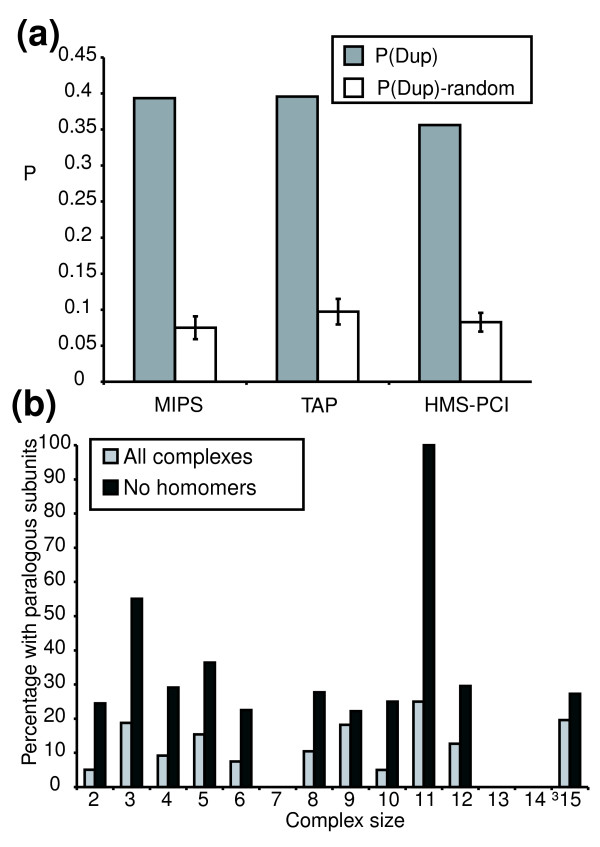
Duplication of subunits in protein complexes. (a) Nearly 40% of the protein complexes have homologous subunits (gray bars). These levels are higher than expected by chance (white bars). Random expectation levels are the averages of 10,000 randomized protein complex datasets, where the complex size distribution is kept constant. While the MIPS dataset is the result of manual curation (see table 1), both TAP and HMS-PCI are the result of large-scale experiments, and some redundancy may exist from multiple baits picking up the same complex. For the TAP dataset, the authors provide a smaller set of predicted complexes based on bioinformatics methods. We repeated the calculation on this set of predicted TAP complexes and found that 47% of the complexes have duplicated subunits, while 18 ± 2% would be expected at random. The significance level remains the same for this predicted set of complexes as for the raw purification data. (b) Percentage of complexes of known three-dimensional structure that have duplicated subunits, as a function of complex size. Grey bars are for the complete data set, whereas black bars are from a dataset that excludes purely homomeric complexes, as these dominate the dataset (see Table 1) and may distort the results. On average, between 9% and 30% of the complexes display duplicated subunits (including and excluding purely homomeric complexes, respectively). This is not an artifact introduced by the complex size distribution.